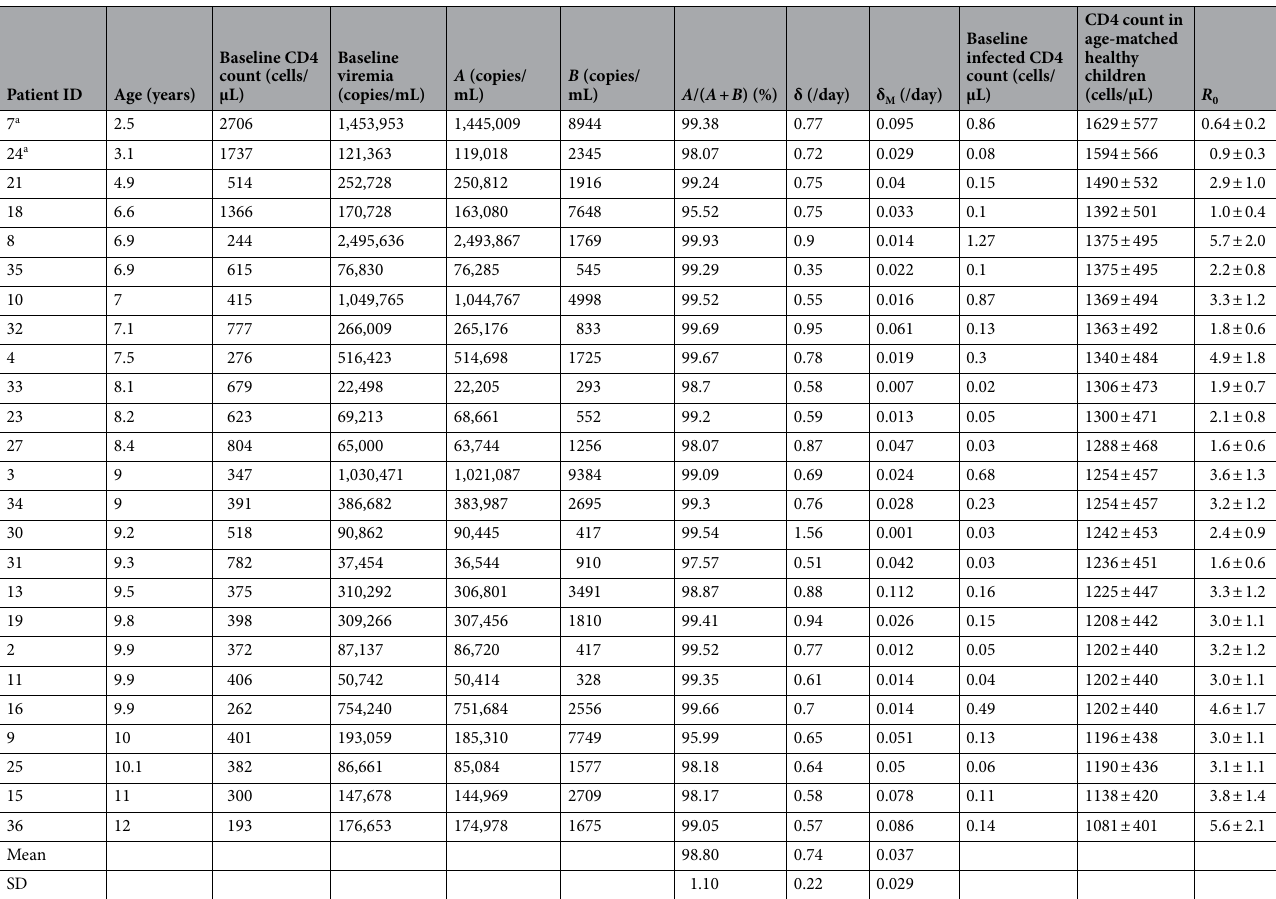
Table 1. Baseline characteristics, best-fit parameter values and estimates of R 0 in Indian children. Age, baseline CD4 counts and viremia of the 25 children analyzed using Eq. (1) are listed. The best-fits (Fig. S1) yielded values of A and B , which mark the contributions to the baseline viremia from productively infected and long-lived infected cells, respectively. 100 × A/A + B thus yields the percentage of the virions at baseline that originated from productively infected cells. The fits also yielded the loss rates of productively infected cells, δ , and long-lived infected cells, δ M . Uncertainties in estimates of A , δ , and δ M are in Table S4. Subtracting the infected cell count at baseline ( Ac/Nδ ) from the CD4 count yielded an estimate of the uninfected target CD4 count at baseline (see “Methods”). Dividing the CD4 count in healthy individuals of the same age (Fig. S4) with the latter uninfected target CD4 count yielded the basic reproductive ratio, R 0 . Means and standard deviations are reported for quantities that are not correlated with age. a The baseline CD4 count in these very young children was larger than the mean count in healthy children, resulting in estimates of R 0 <